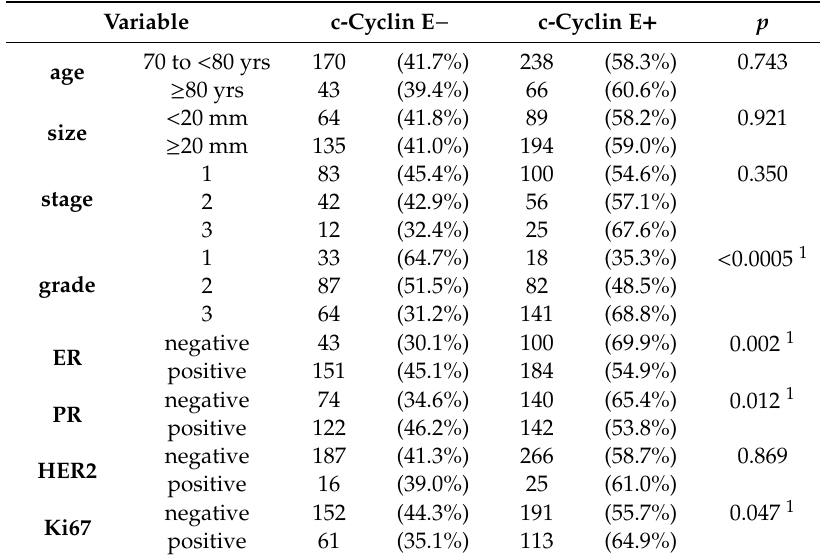
Table 3. Association between tumor c-cyclin E status and clinicopathological factors.